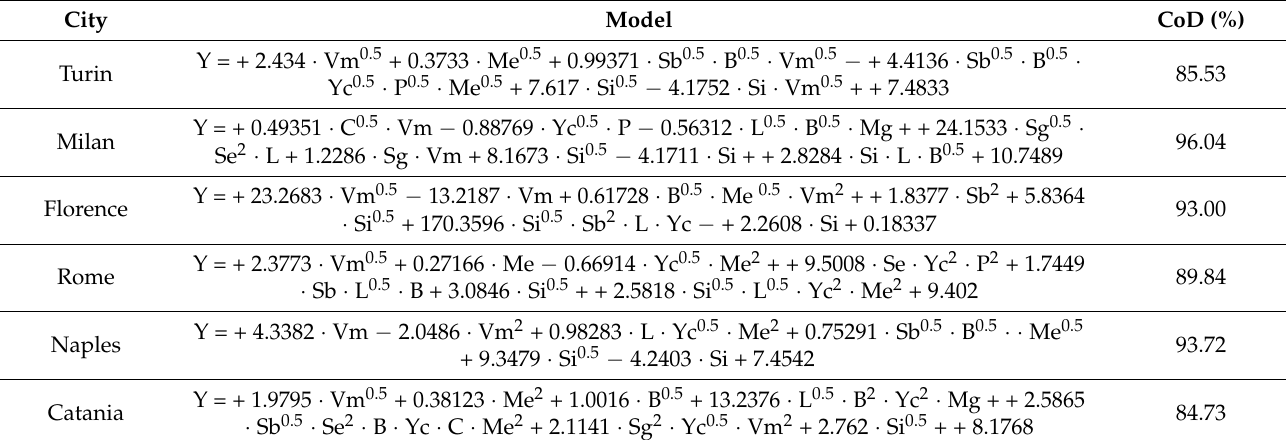
Table 6. Models generated by the EPR-MOGA implementation for each Italian city analyzed for the Phase II. City Model